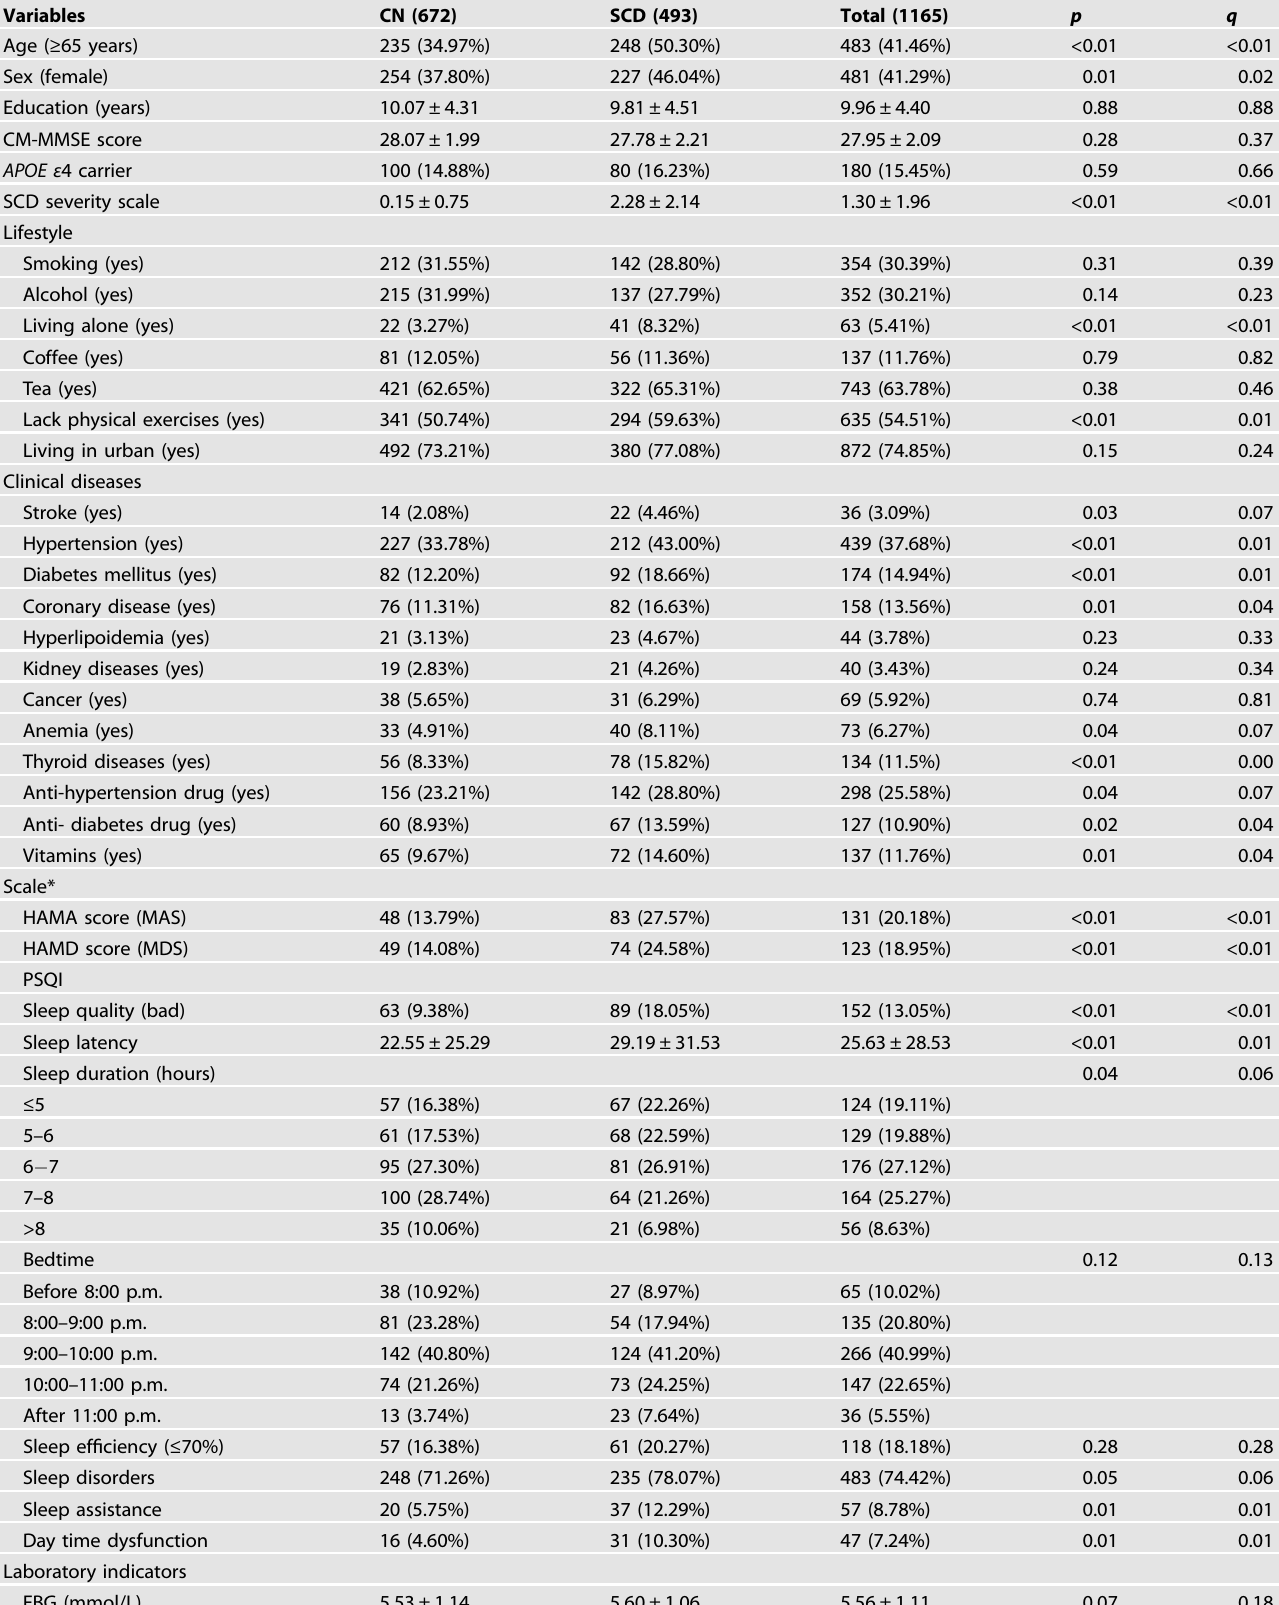
Table 1. Characteristics of